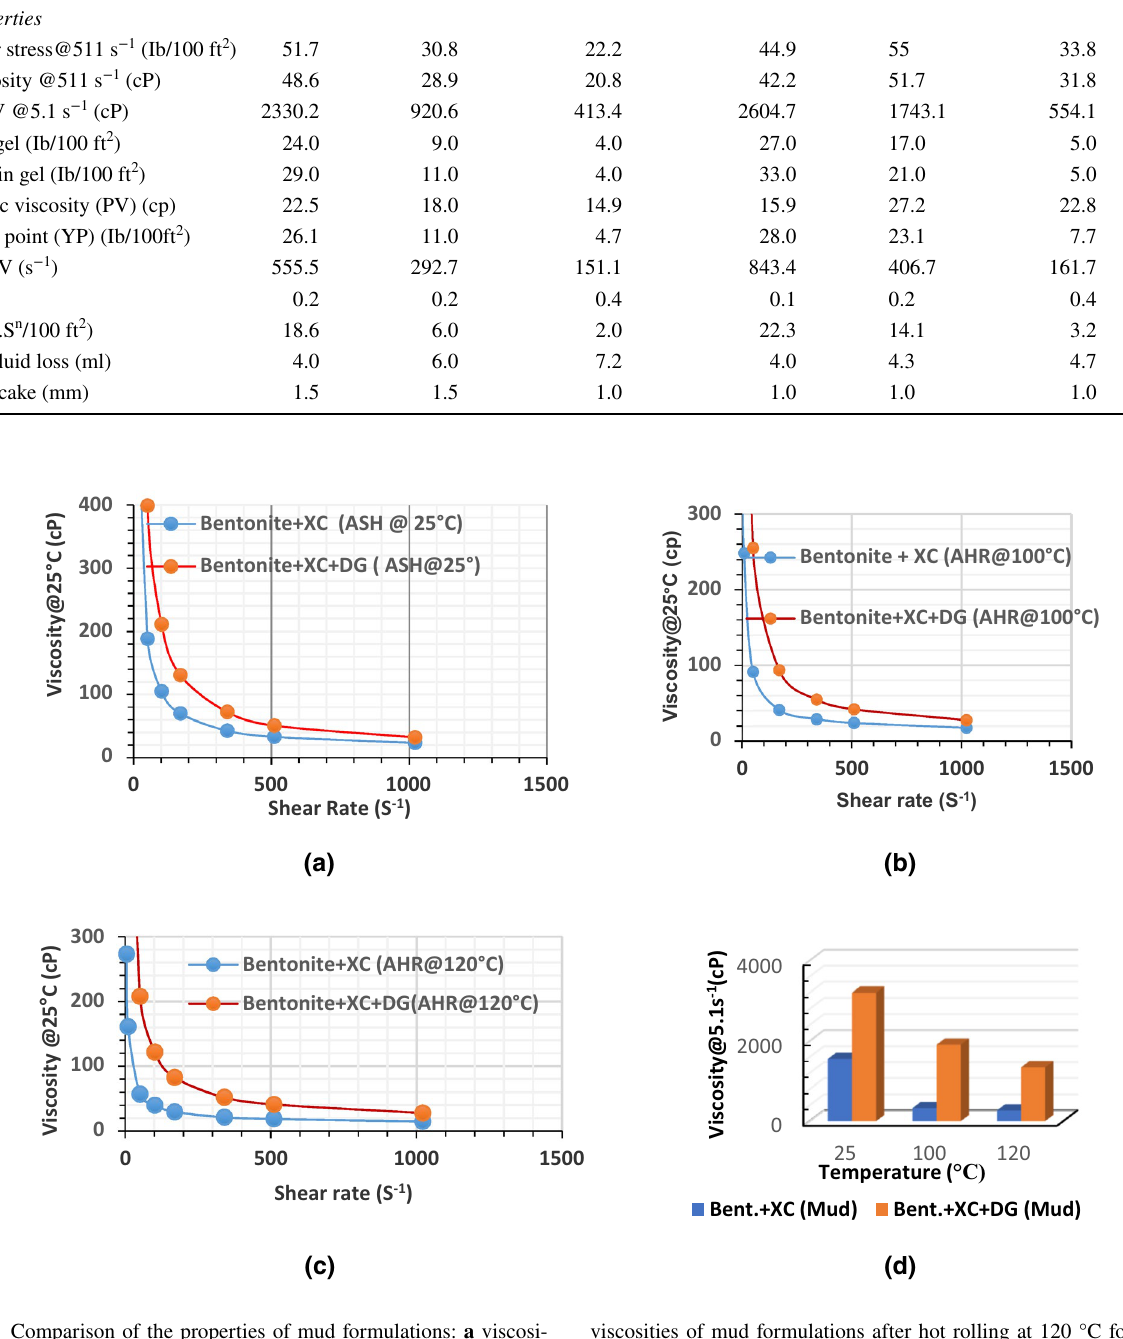
viscosities of mud formulations after hot rolling at 120 °C for 16 h; d low shear rate viscosities of the mud formulations after aging at 25 °C, 100 °C, and 120 °C for 16